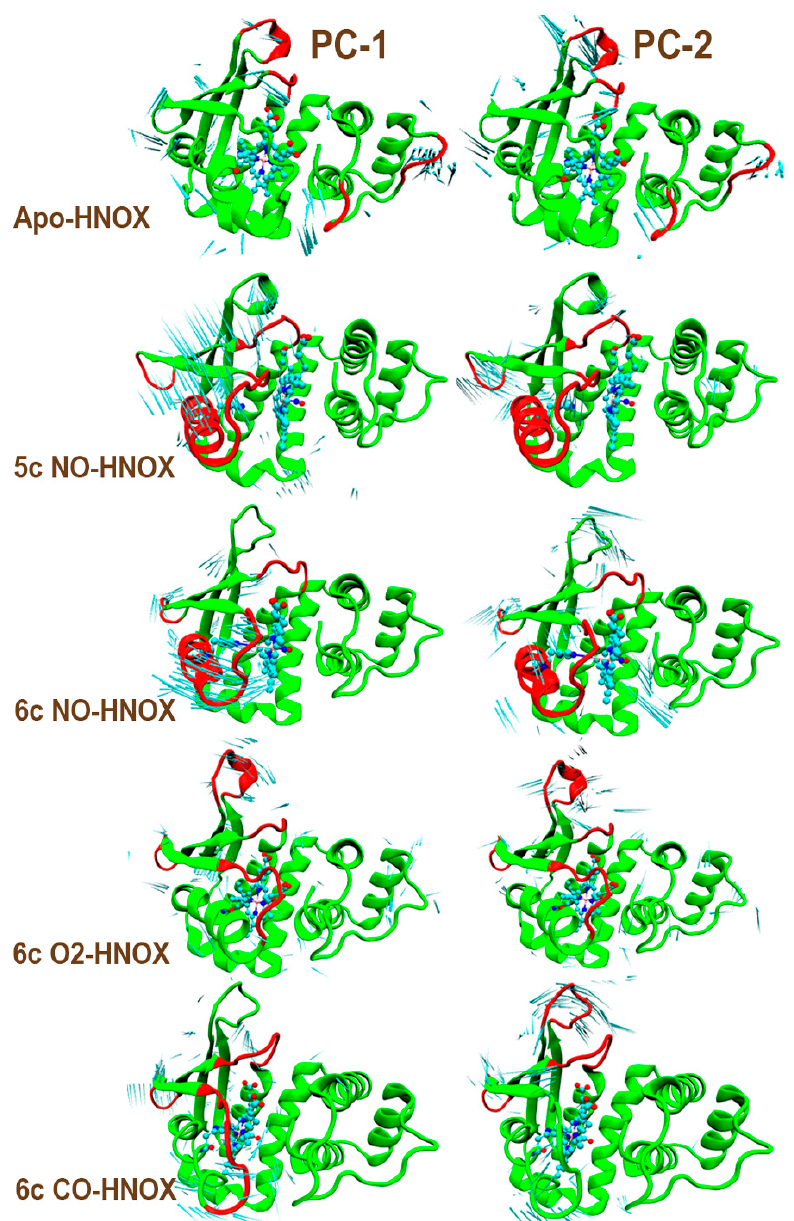
Figure 8. Porcupine plot illustrating the highest principal component variance of the first (PC-1) and second (PC-2) modes of motion. Highly fluctuating regions are highlighted in red. The length of the cyan “needles” represents the degree of mobility.